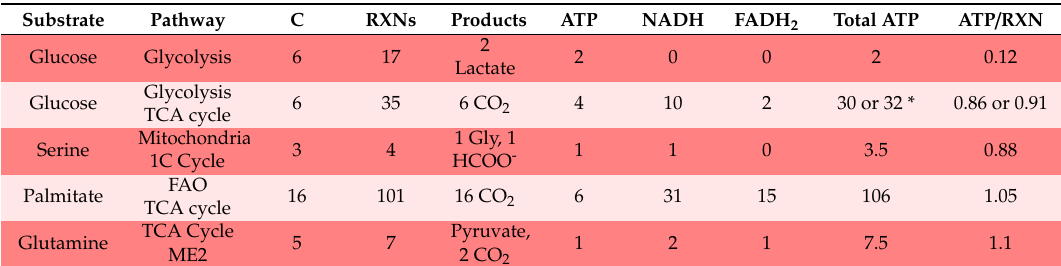
Table 1. ATP and co-factors produced from glucose, palmitate, serine and glutamine when bioenergetics are the main metabolic constraint. Glucose can either be oxidised to 2 lactate or to 6 CO 2 molecules. One carbon (1C) metabolism can generate 1 ATP if only the mitochondrial 1C cycle is run and the end-product formate is not recycled. MTHFD2 / L has two separate enzyme activities, a dehydrogenase and a hydrolase activity. Complete oxidation of a fatty acid e.g., palmitate yields 16 CO 2 and generates energy in the form of 6 ATP, 31 NADH and 15 FADH 2 molecules. Breakdown of glutamine in the TCA cycle and subsequent conversion of malate to pyruvate through the action of malic enzyme 2 (ME2) generates 1 ATP, 1 NADH and 1 FADH 2 molecule. Total ATP for each reaction is calculated based on ATP molecules generated, each NADH molecule producing 2.5 ATP molecules and FADH 2 producing 1.5 molecules of ATP molecules upon OXPHOS. * Depending on the shuttle system used to transport cytosolic NADH to the mitochondrion, 2.5 or 1.5 ATP molecules can be produced per molecule cytosolic NADH in this case [142]. Gly, glycine; HCOO - , formate; FAO, fatty acid oxidation; TCA, tricarboxylic acid; ME, malic enzyme; RXN, reaction; C, carbons per substrate molecule.